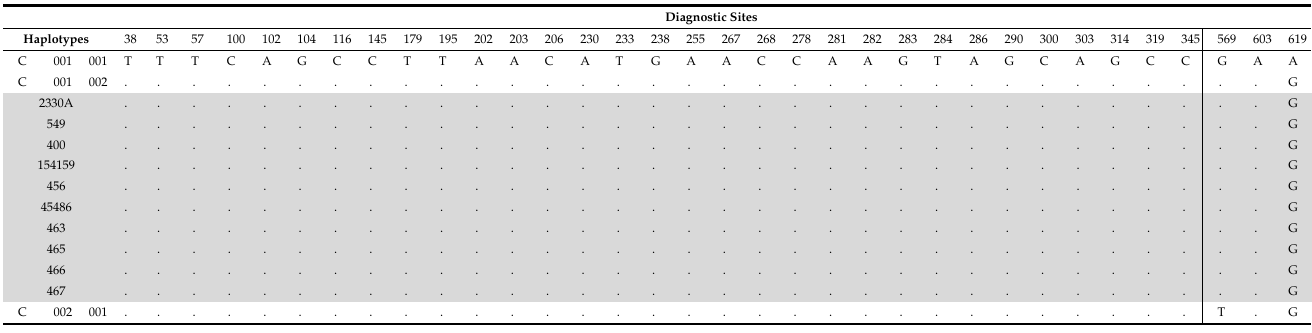
Table 2. Result of the alignment of the 619 bp sequences of the mtDNA control region obtained in this work (in grey) and haplotypes classified as “haplotype C” based only on a fragment of 394 bp (region marked by the bold black line). Diagnostic sites shown in this table are those obtained aligning all the haplotypes described so far for P. macrocephalus at global level (see [20]). All sites identical to those in the reference sequence are indicated as full stops.